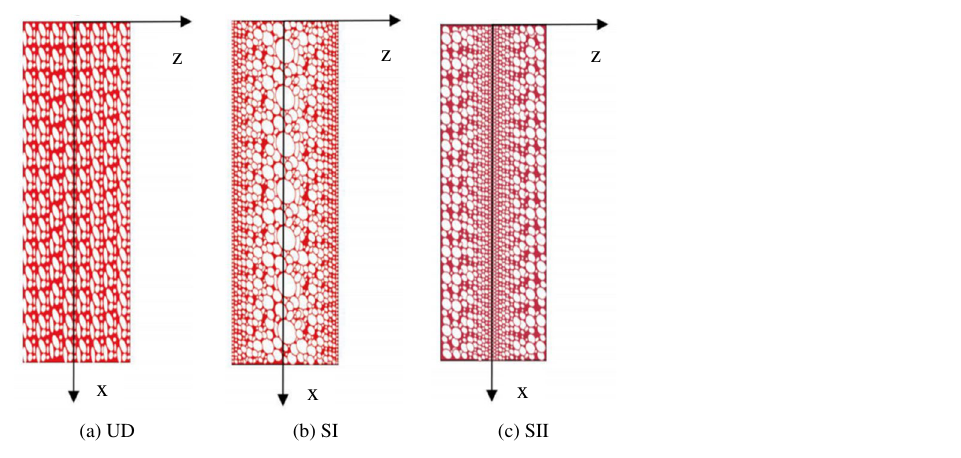
Figure 2. Porosity distribution patterns 37